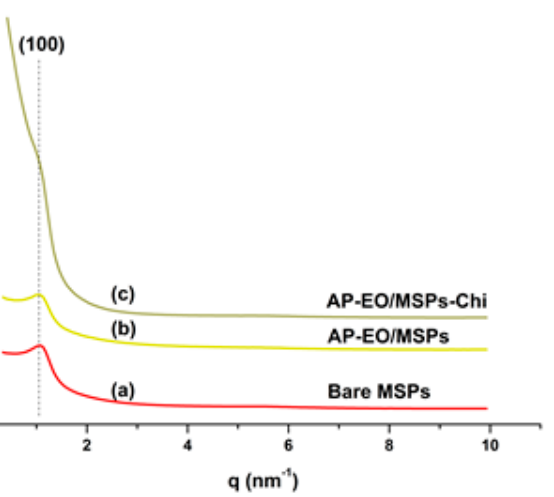
Figure 4. SAXS patterns of ( a ) mesoporous silica particles (MSPs), ( b ) A. pusila essential oil encapsulated in MSPs (AP-EO/MSPs), and ( c ) AP-EO/MSPs coated with chitosan (AP-EO/MSPs-Chi).